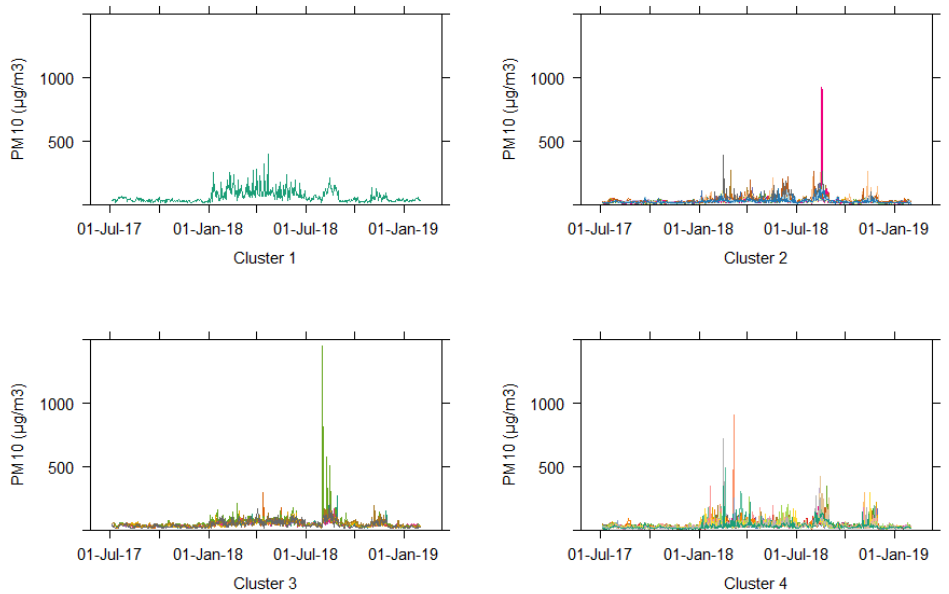
Figure 14. Time series plots for each cluster formed based on DTW and PAM for daily maximum PM 10 time series data.